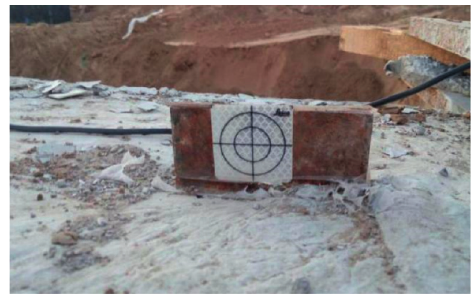
Figure 7: Reflective sheet in pile top.